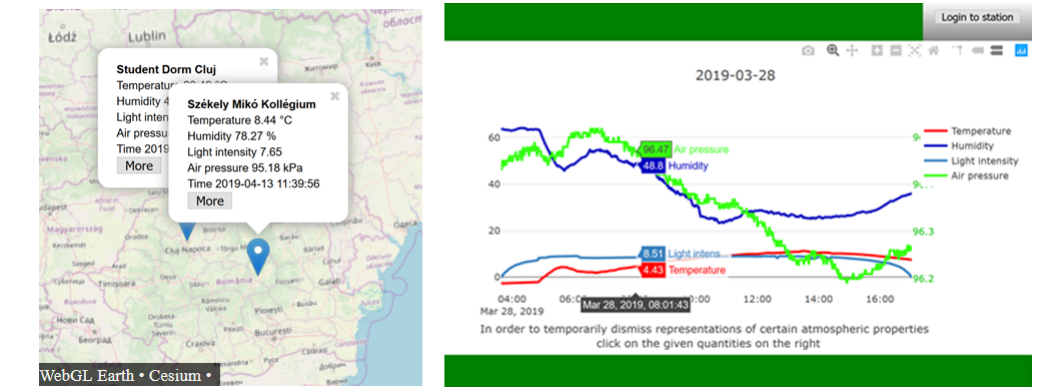
Figure 5. The fixed mini meteo stations website (http://globalweather.000webhostapp.com/index.php, last access: 29 May 2019), by A. Medgyesi, 12th grade student.